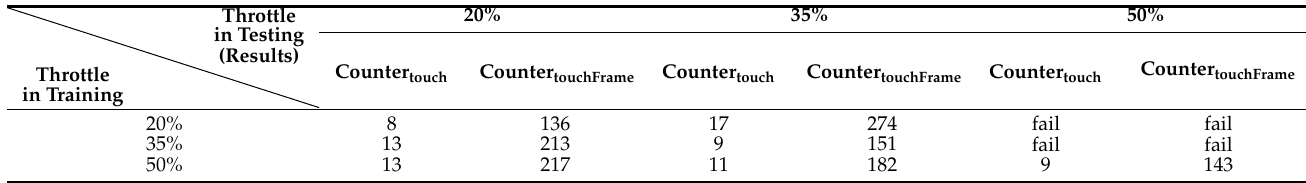
Table 3. Comparison results of training and testing of the autonomous vehicle for 10 laps with different